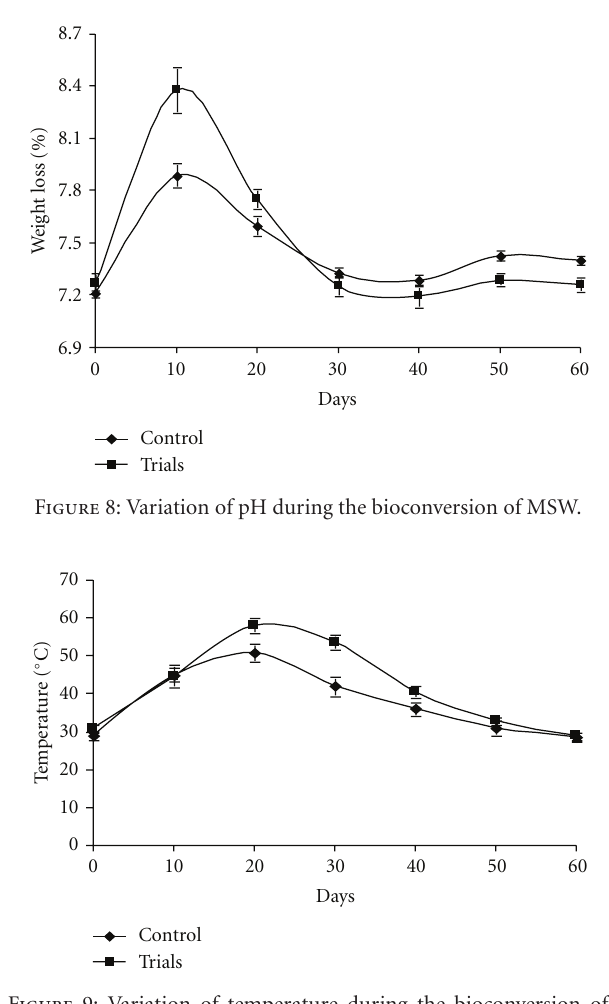
Figure 9: Variation of temperature during the bioconversion of